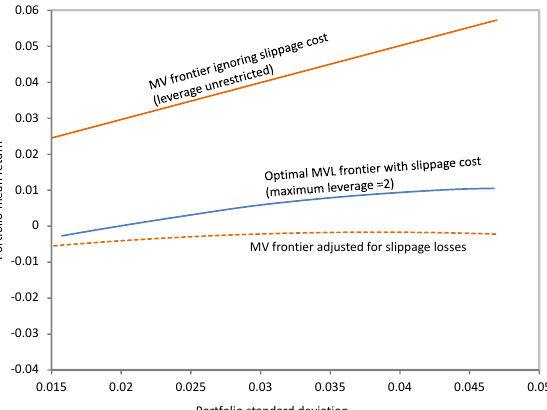
Figure 4. Effect on MV efficient frontiers due to market impact (leverage risk aversion, θ = − 1.6449).